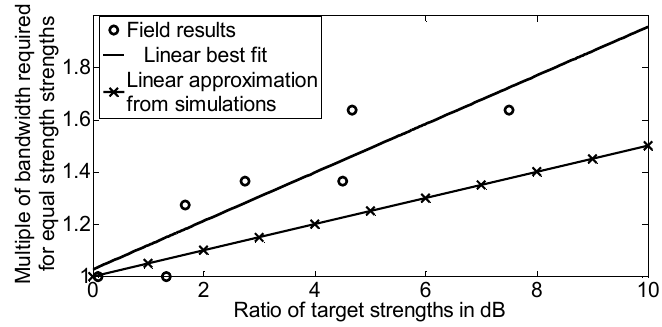
Figure 17. Dependance of bandwidth on target strength ratio.